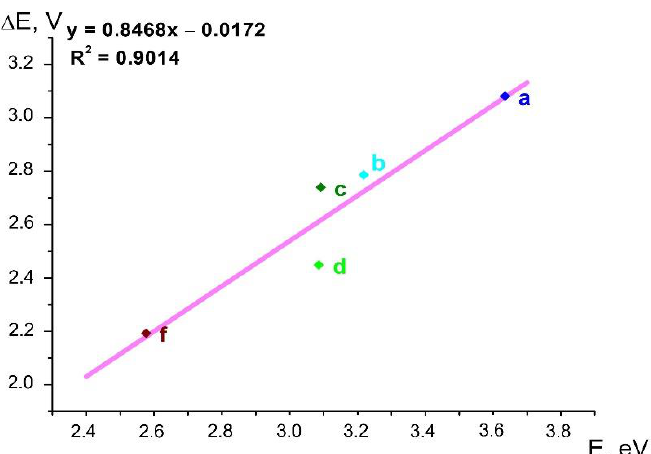
Figure 12. Linear correlation between the energy E of the long-wavelength absorption maximum and the difference ΔE of the oxidation/reduction potentials for dienones 1a – d , f . The coefficient of determination R 2 and regression equation are